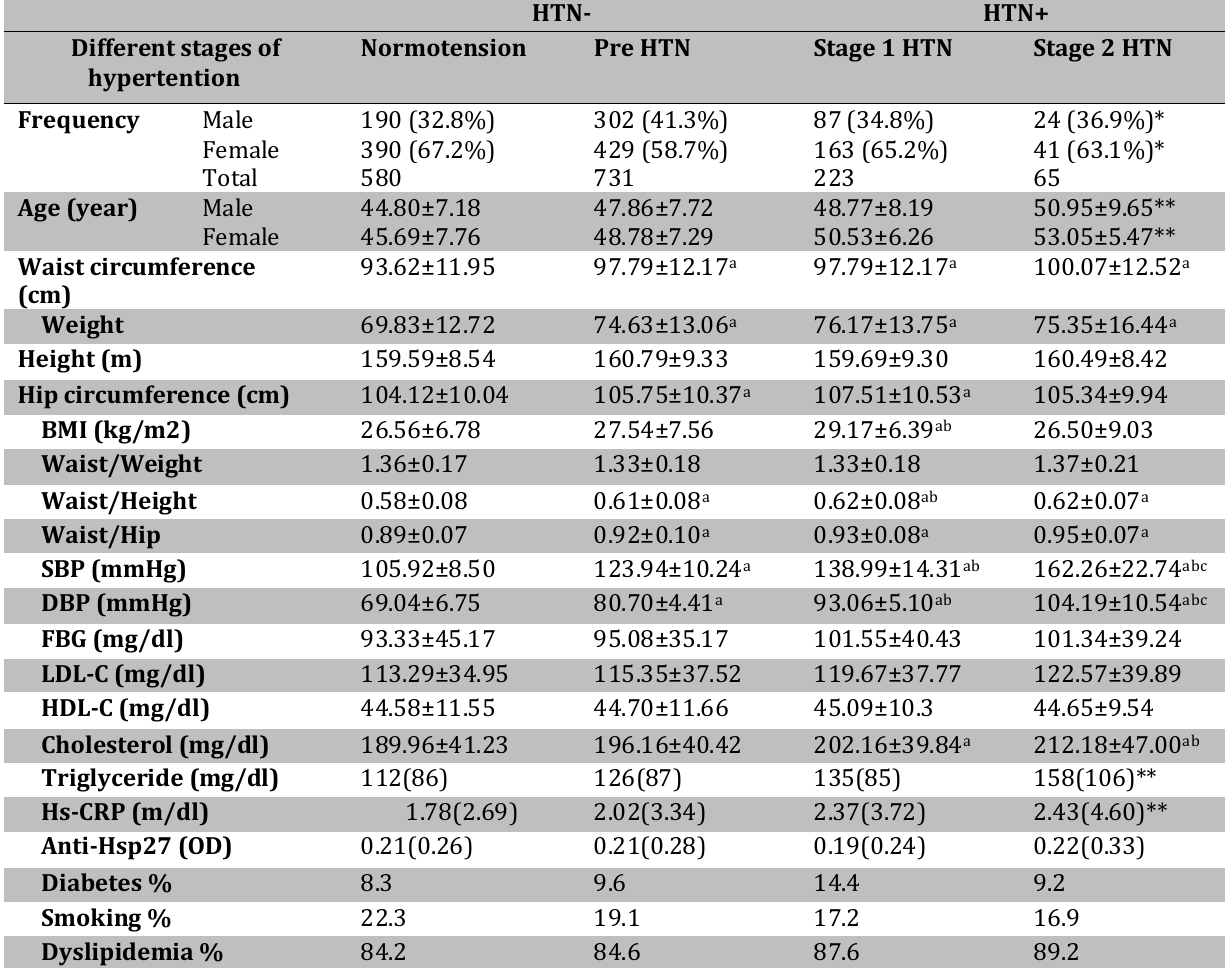
Table 1. Comparison of the baseline characteristics between hypertensive (HTN+) and non-hypertensive (HTN-)